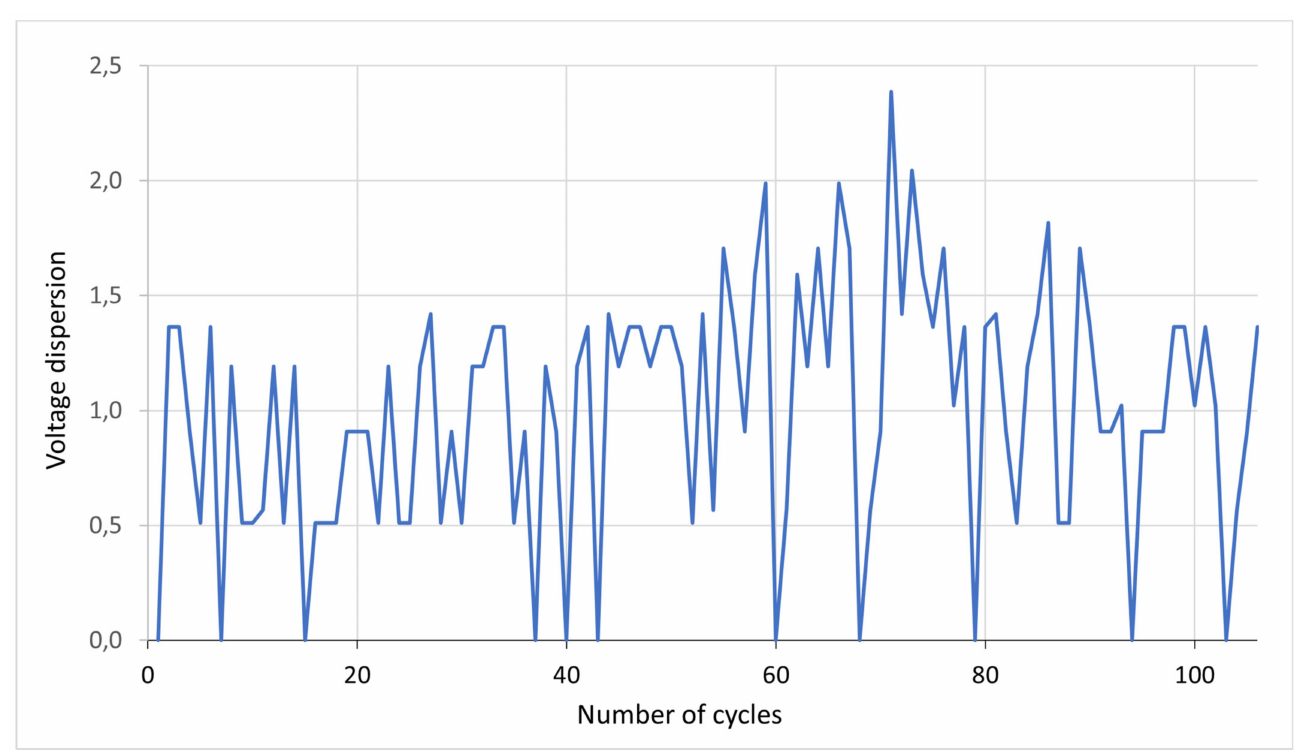
Figure 9. Voltage dispersion battery